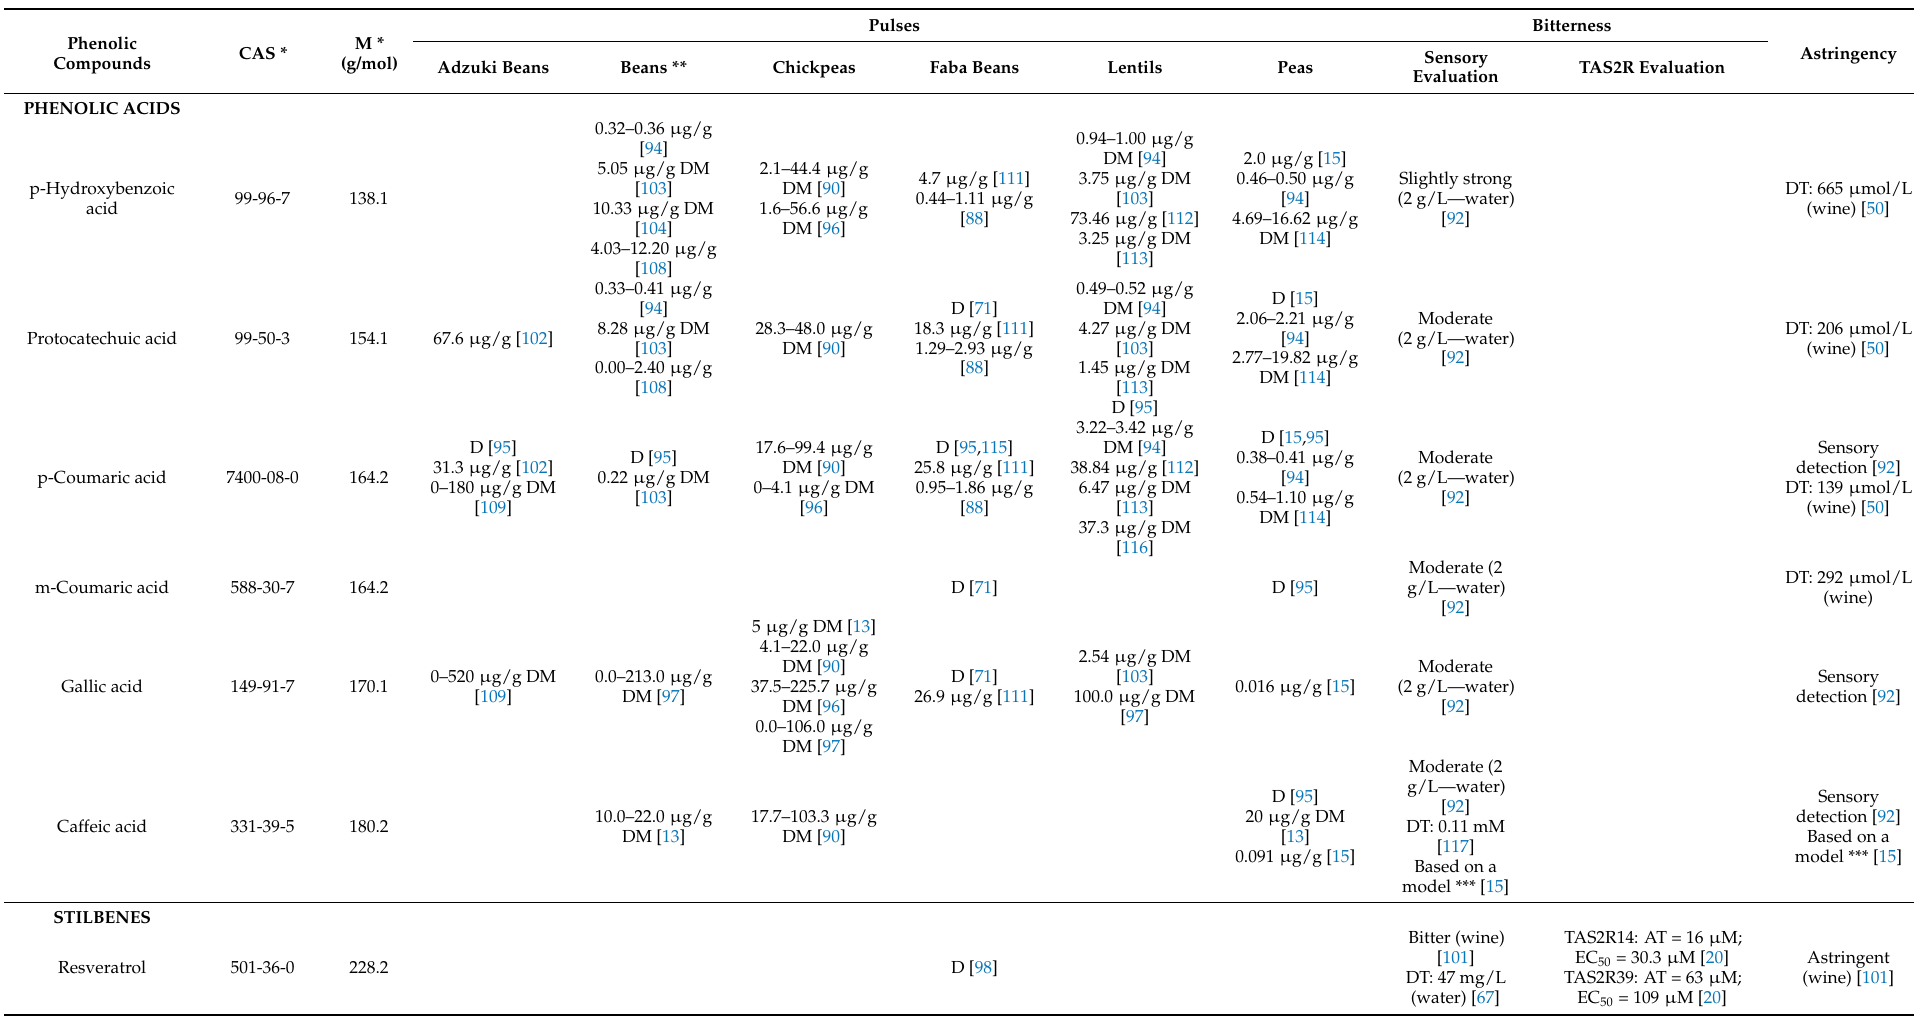
Table 3. Phenolic compounds identified in pulses and their bitter and astringent